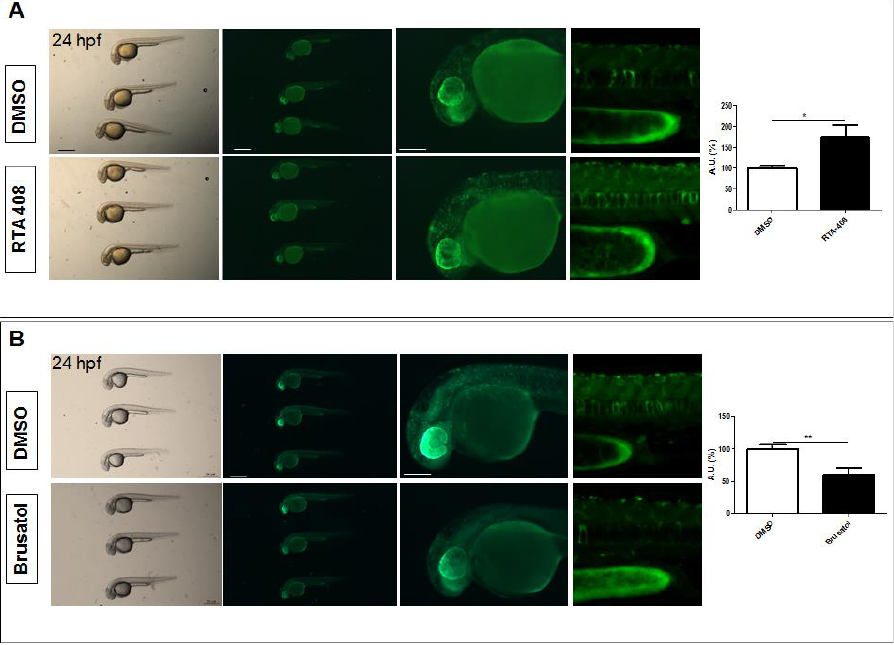
Figure 2. Pharmacological validation of Nrf2/ARE reporter fish. ( A ) Whole-mount bright field and fluorescence microscopy acquisition of a 24 hpf transgenic larva treated with DMSO and the Nrf2 pathway agonist, RTA-408, for 16 h. A significant increase in fluorescent cells is detected in RTA-408-treated larvae when compared to DMSO-treated fish. ( B ) Whole-mount bright field and fluorescence microscopy acquisition of a 24 hpf transgenic larva treated with DMSO and the Nrf2 pathway antagonist, Brusatol, for 16 h. A visible decrease in reporter fluorescent intensity is visible in Brusatol-treated larvae. All images are lateral views with anterior to the left. The magnifications of the trunk regions are confocal Z-stack acquisitions. The graphs reported on the right depict the ImageJ-based quantification of the selected trunk region of 5 independently treated fish (* p < 0.05; ** p < 0.005, t -test). Scale bars in the panels with multiple fish: 500 μ m; scale bars on the panels with a single magnified larva: 100 μ m.